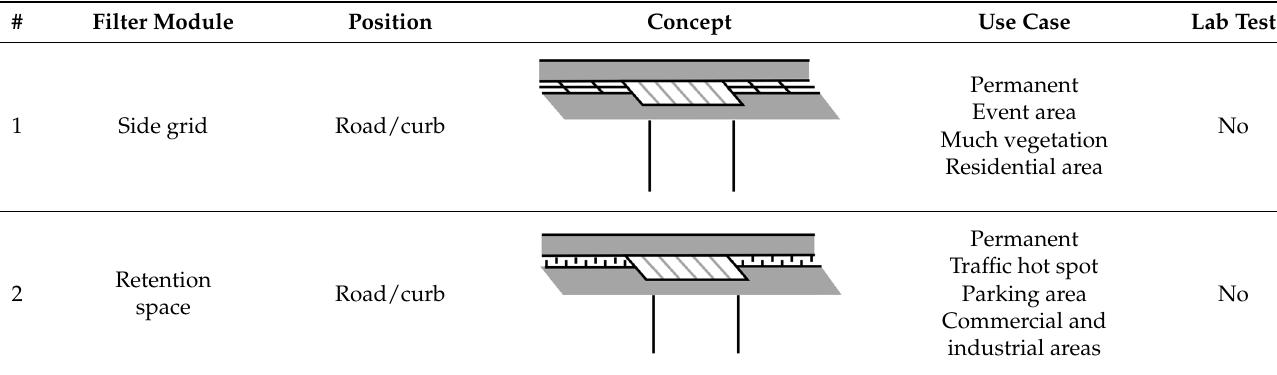
Table 2. Overview and evaluation of the tested filter modules.